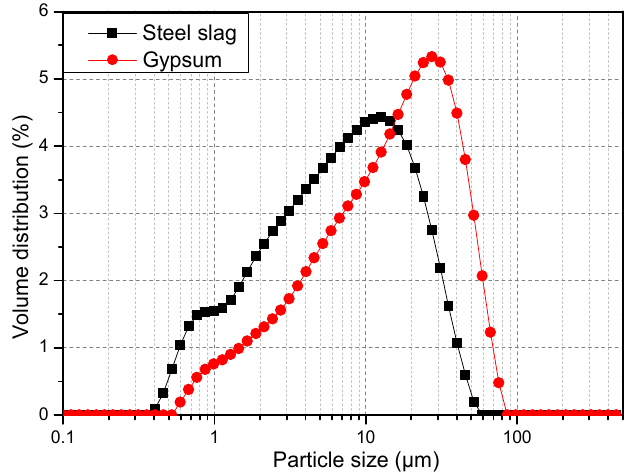
Figure 3. Particle size distributions of the SS and DG.